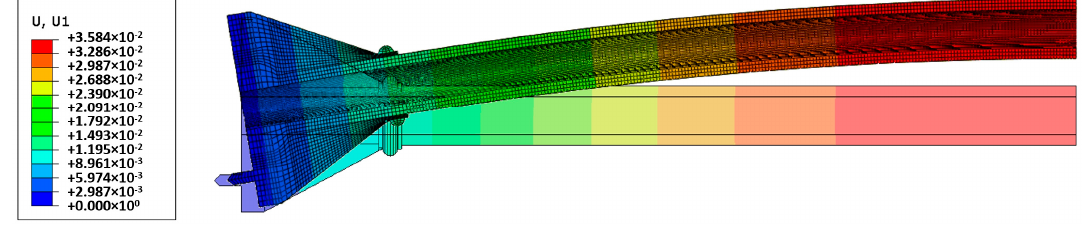
Figure 10. Nonlinear analysis of the original column for N = 117 kN. Distribution of lateral displacements.